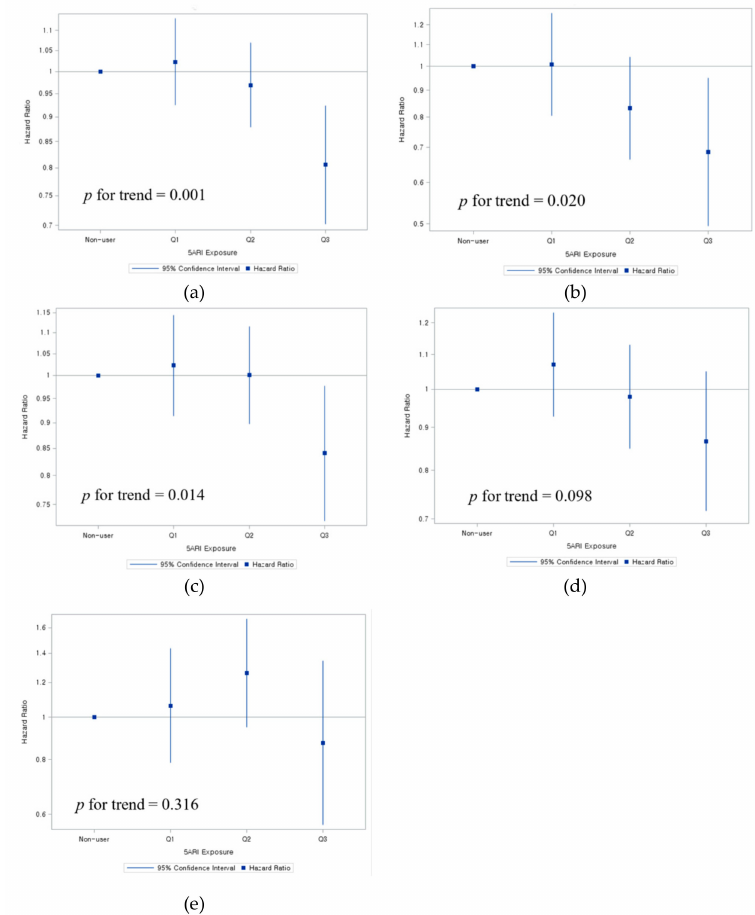
Figure 2. Hazard ratios of tertiles of 5ARI users among the BPH patient subcohort. ( a ) Hazard Ratio for Cardiovascular Disease. ( b ) Hazard Ratio for Myocardial Infarction. ( c ) Hazard Ratio for Stroke. ( d ) Hazard Ratio for Ischemic Stroke. ( e ) Hazard Ratio for Hemorrhagic Stroke. Hazard ratios were estimated using a multivariate cox proportional hazard model (Wald χ 2 test p value < 0.001) adjusted for age, hypertension, diabetes, high cholesterol, body mass index, smoking habit, alcohol consumption frequency, exercise frequency, socioeconomic status in quartiles, benign prostatic hyperplasia, acute urinary retention, atrial fibrillation or flutter, angina, Charlson Comorbidity Index, outpatient visits, alpha-blocker use, aspirin use, NSAID use, HMG-CoA reductase inhibitor use, and year of BPH